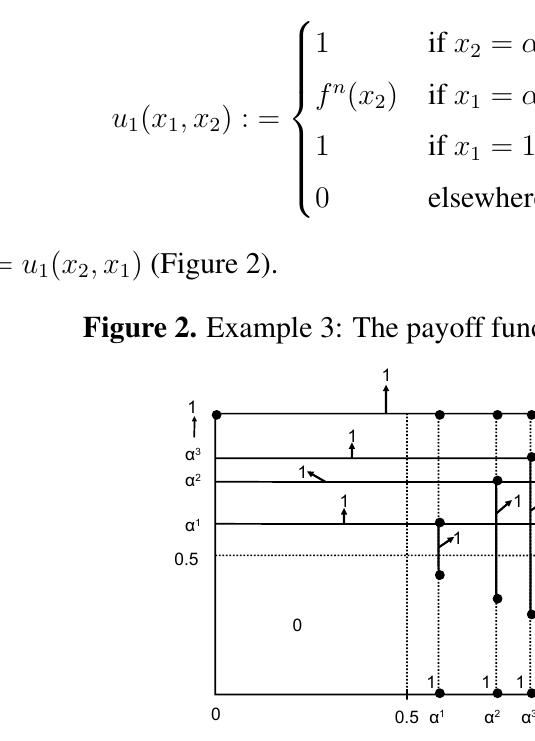
Figure 2. Example 3: The payoff function for player